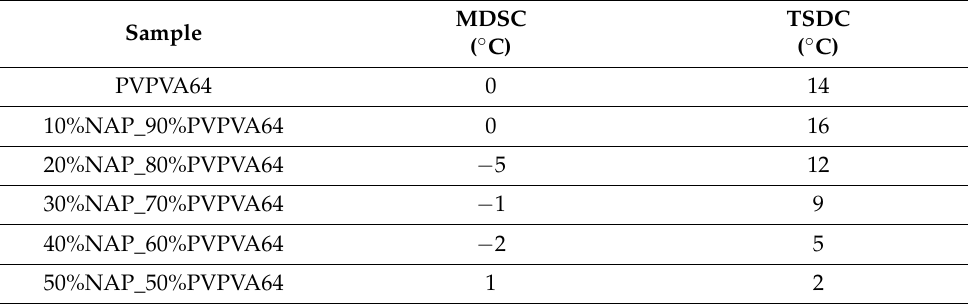
Table 2. Deviation of the measured T g values from the calculated